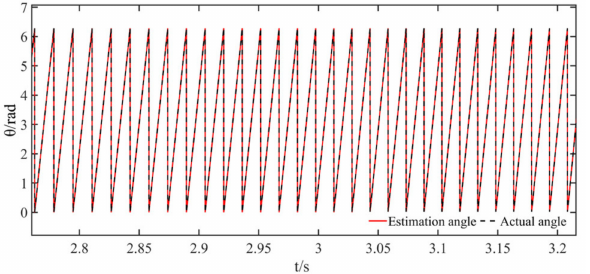
Figure 14. Rotor position angle waveforms during acceleration process.